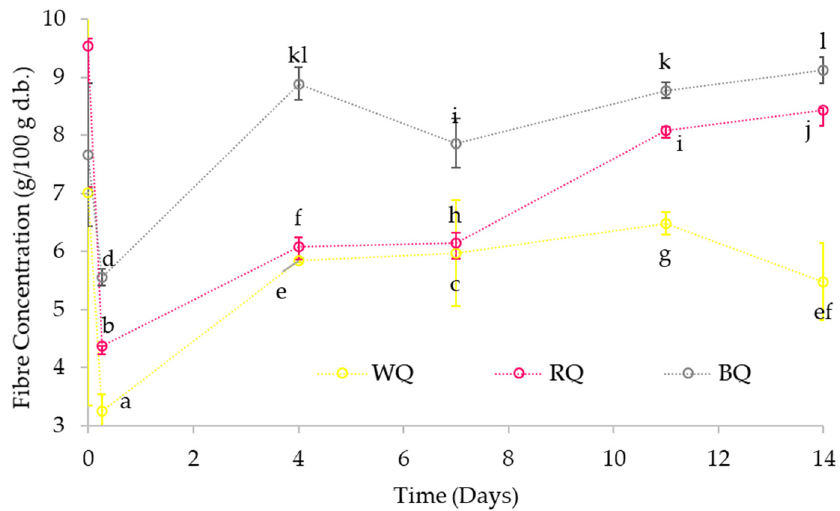
Figure 3. Fibre content variation for white (WQ), red (RQ) and black (BQ) quinoa during soaking (0.25 days), germination (4 and 7 days at 20 °C and 100% RH), and refrigerated storage (11 and 14 days at 4 °C and 75% RH). Error bars indicate standard deviation ( n = 3). Results with different letters are significantly different at p ≤ 0.05.